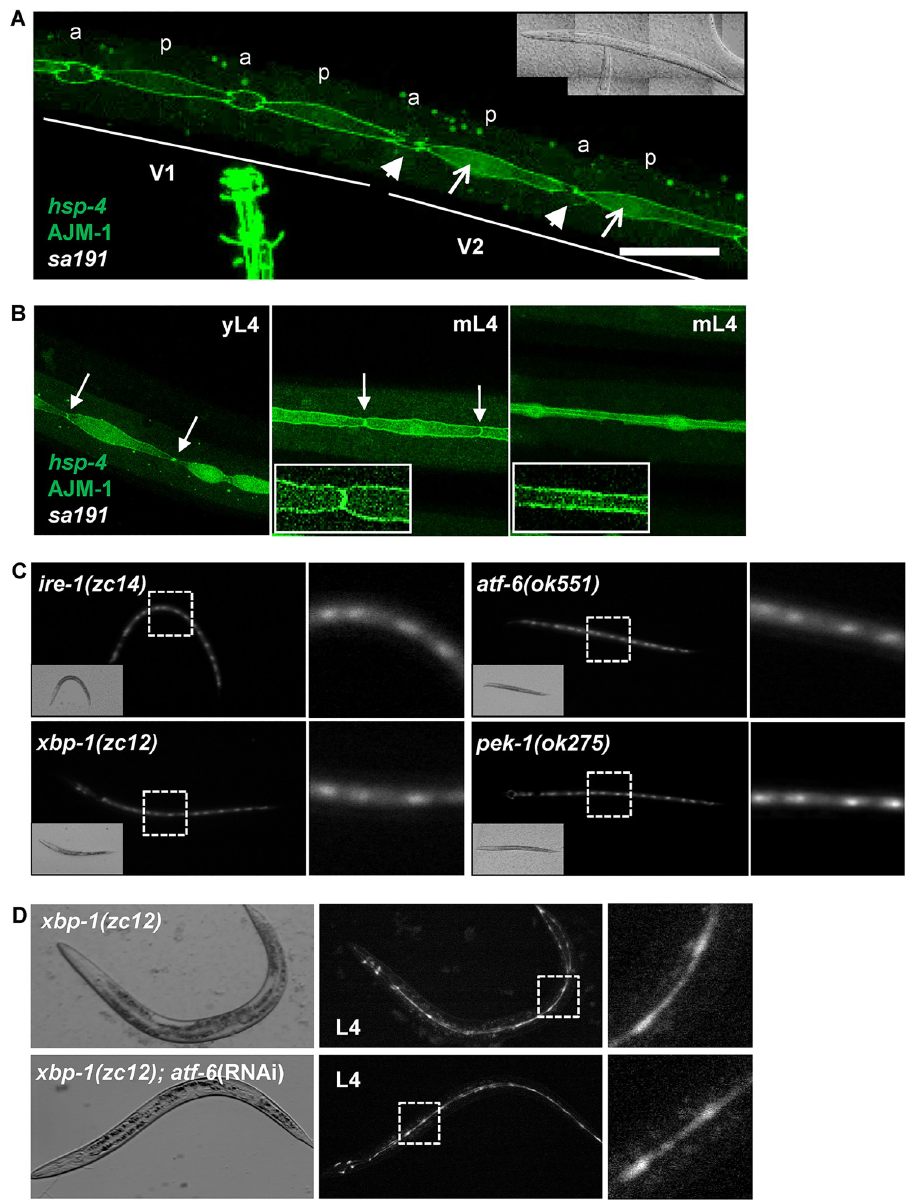
Fig 2. Expression of hsp-4 is induced early during differentiation, independent from UPR signaling. (A) Confocal images of V1 and V2 lineage cells of a daf-28(sa191) early L2d animal (39 hours post-gastrula stage), expressing p hsp- 4 ::GFP reporter and AJM-1::GFP fusion protein. Open arrows point to already visible induction of hsp-4 reporter in posterior daughters (p), which are outlined by the AJM-1::GFP protein; arrowheads point to the remnants of apical junctions of the differentiating anterior daughters (a). Inset: transmitted light, entire animal. Scale bar: 20 μ m. (B) Seam cells of WT animals expressing p hsp -4::GFP reporter and AJM-1::GFP fusion protein. yL4 stage, left panel; mL4 stage, prior to (middle panel) or after (right panel) seam-cell fusion. Arrows point to the junctions between cells, which disappear after the fusion. Main panels: z-stack projections; insets: single-plane images showing the AJM-1::GFP protein outlining either the cell boundaries prior to fusion (middle panel) or the seam syncytium (right panel). (C) Expression of hsp-4 reporter in the seam cells of starvation/crowding-induced predauers of indicated UPR-deficient mutant strains. All animals carry the p hsp-4 ::GFP transgene. Imaging as in Fig 1A. (D) Combined loss of XBP-1 and ATF-6 transcription factors does not prevent hsp-4 induction in differentiating seam cells. Upper panels, xbp-1(zc12) animal fed control RNAi (L4440 empty vector); lower panels, xbp-1(zc12) animal fed atf-6 RNAi for two generations. AJM, Apical Junction Molecule; ATF-6, Activating Transcription Factor 6; daf-28(sa191) , an allele causing ectopic L2d entry; GFP, green fluorescent protein; HSP-4, Heat-Shock Protein 4; L2, second larval stage; L2d, predauer L2;